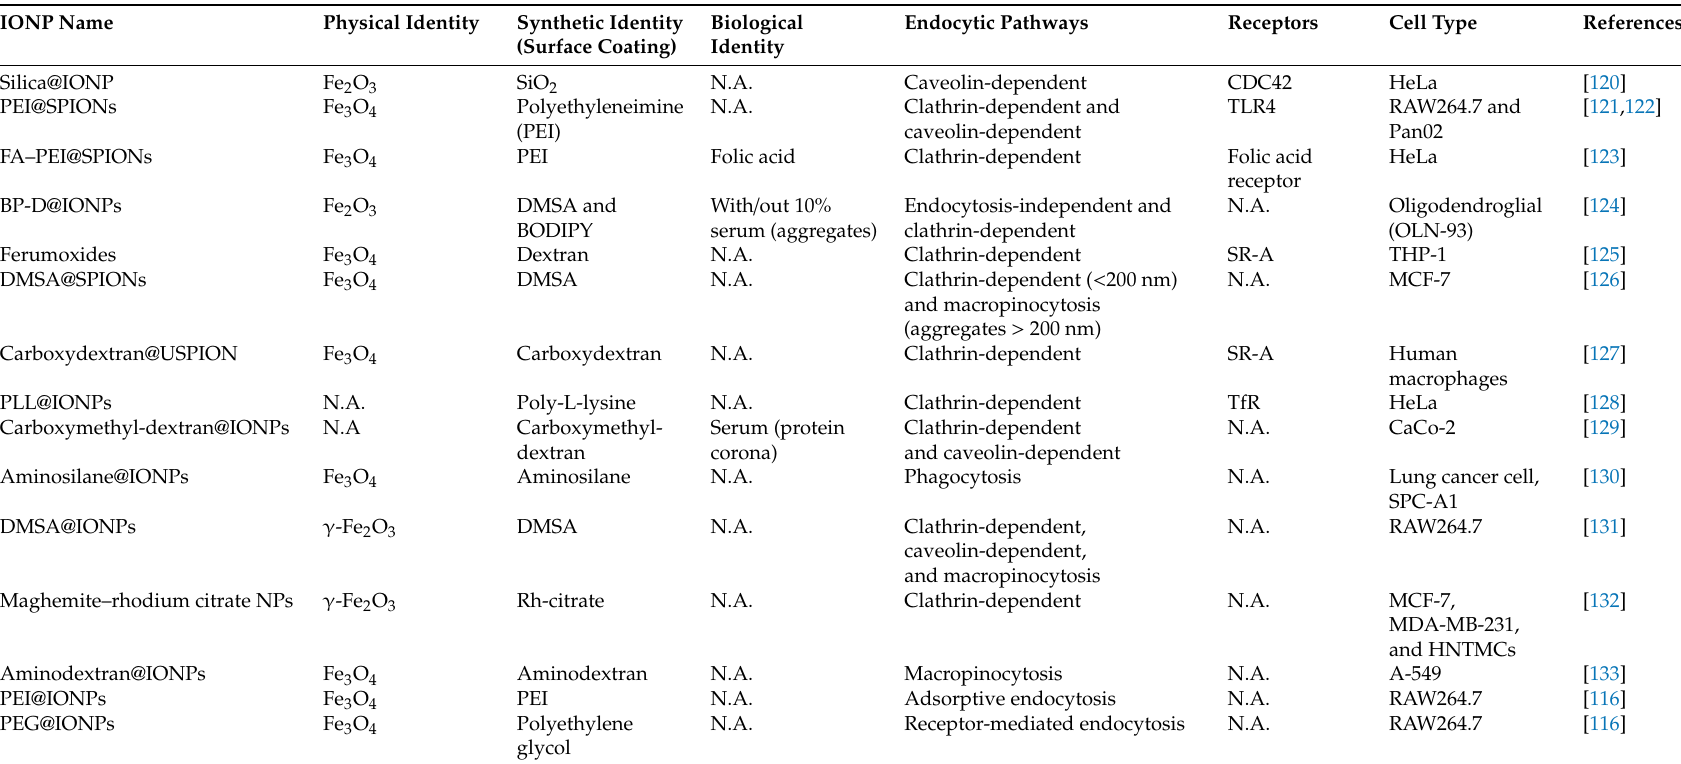
Table 3. Examples of IONPs and the endocytic pathways that mediate IONP internalization. IONPs are defined according to their identities as referred to in Table 1. The proposed receptors mediating their endocytosis are listed. (N.A.: not